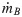
Slice plots at z = 0 showing the production rates (in ng/h).Plots show (a) bacterial cell (m˙B) and (b) EPS (m˙E) for Case A-2 when the total number of cells is around 5000. (Only bottom half of computational domain is shown).